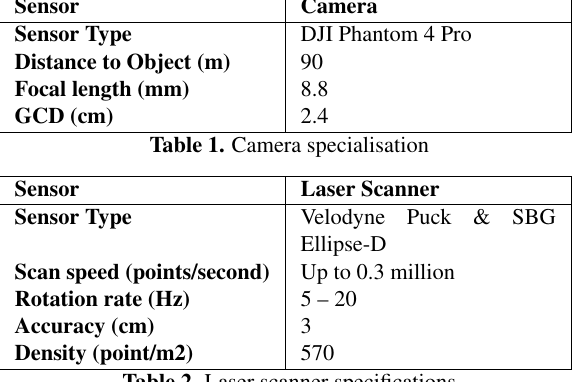
Table 2. Laser scanner